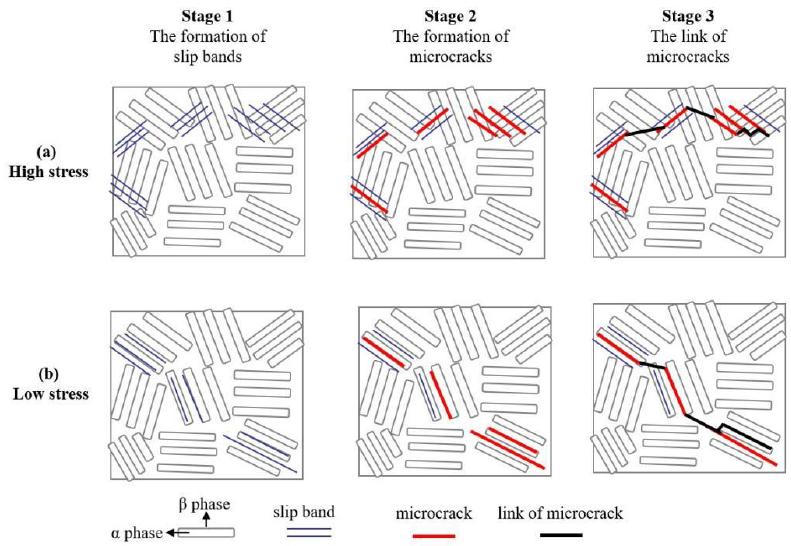
Figure 13 . Three stages of LCF microcracks damage: ( a ) high stress; ( b ) low stress. Figure 13. Three stages of LCF microcracks damage: ( a ) high stress; ( b ) low